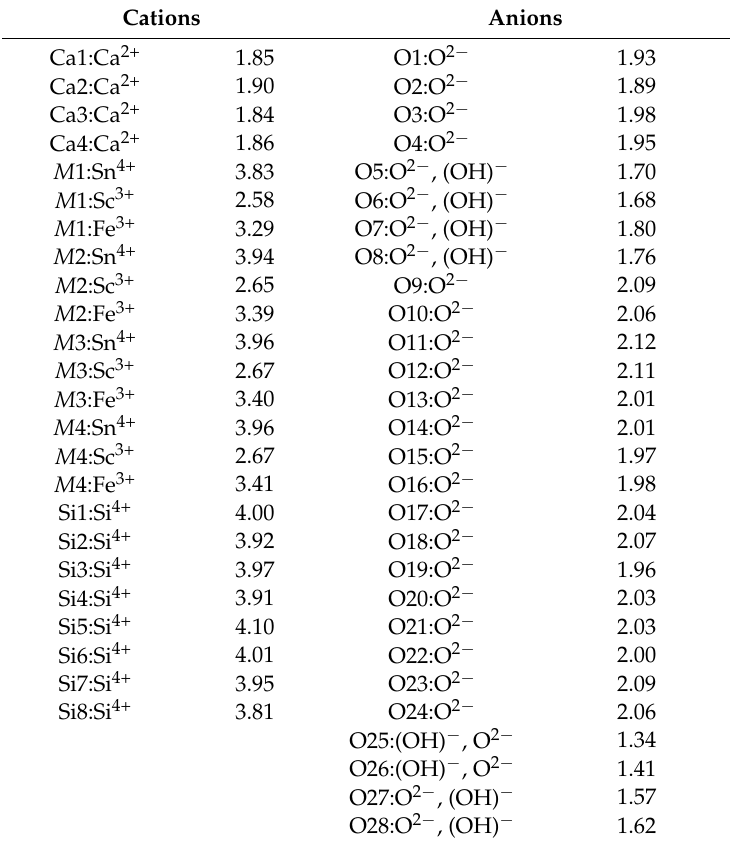
Table 5. Bond valences (calculated with parameters from Brese and O’Keefe,